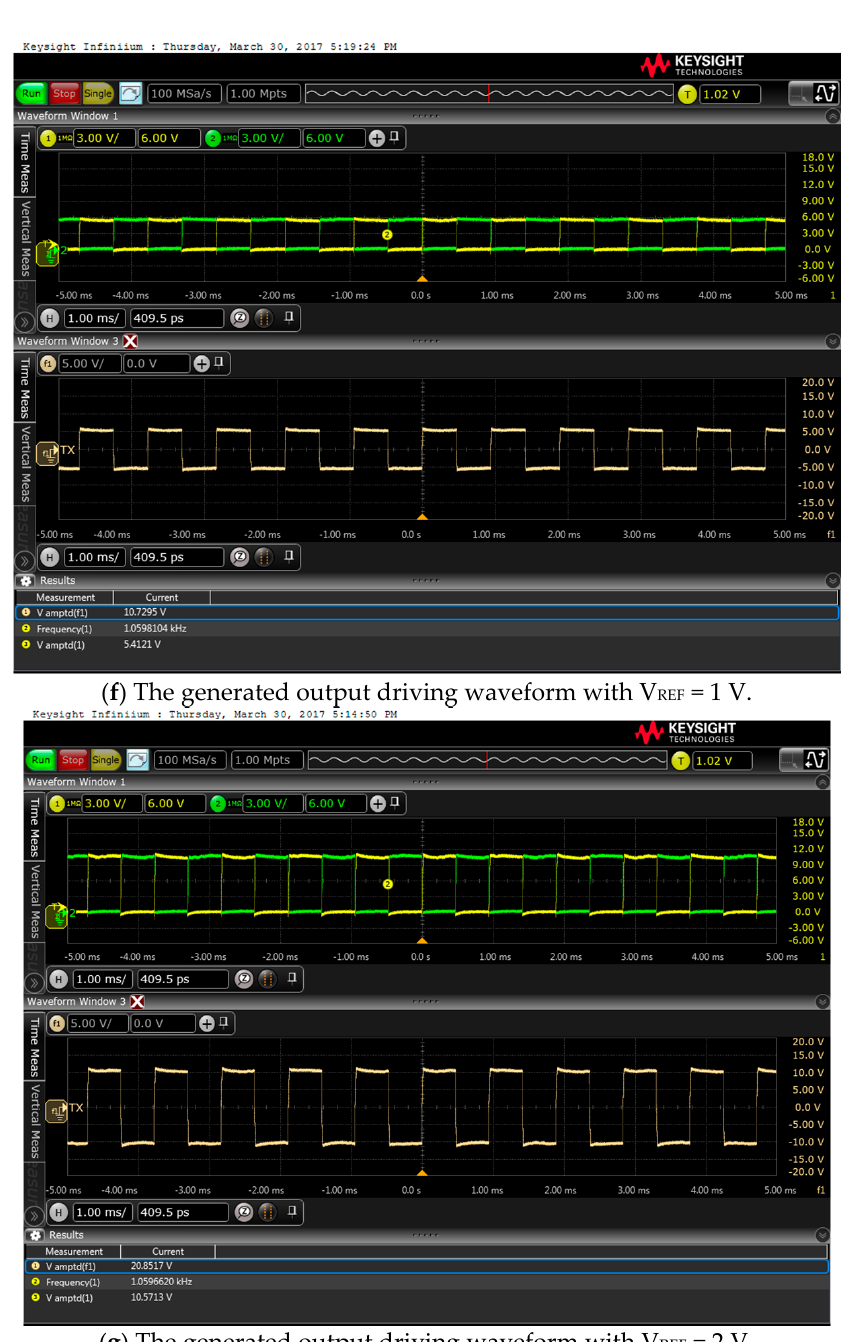
Figure 3. ( a – d ) LC Driver Chip Design Results; ( e ) the circuit boards for testing LC driver chip (The left: the chip testing circuit PCB viewed from top. The right: the circuit board testing the designed LC driver chip); ( f – g ) Chip testing results: the driving waveforms out of the H-bridge for various input reference voltages V REF (The top curves: two differential outputs of half H-bridges; the bottom curve: the full H-bridge output). Table 3. Some testing parameters and results of the designed 2 ‐ channel LC driver chip.